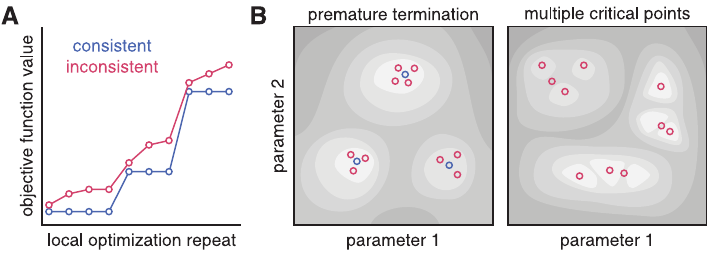
Fig 1. Illustration of final objective function values consistency and possible objective function landscapes. A : Waterfall plot with examples of consistent (blue) and inconsistent (red) final objective function values. B : Possible objective function landscapes that could explain the waterfall plots in